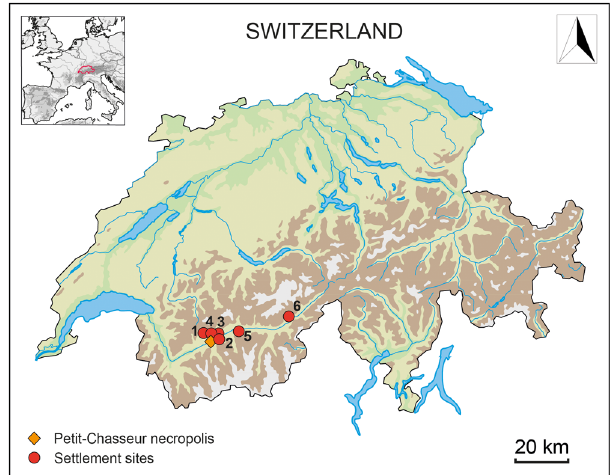
Figure 1: Location in Switzerland of the Petit - Chasseur necropolis and relative position of the Final Neolithic and Bell Beaker sites selected for the study: ( 1 ) Savièse ‘ Château de la Soie ’ ; ( 2 ) Bramois ‘ Pranoé D ’ ; ( 3 ) Sion ‘ Sous - le - Scex ’ ; ( 4 ) Sion ‘ La Gillière ’ ; ( 5 ) Salgesch ‘ Mörderstein ’ ; ( 6 ) Bitsch ‘ Massaboden. ’ General map modi fi ed after the data provided by the Swiss Federal O ffi ce of Topography ( https://map.geo.admin.ch/ )